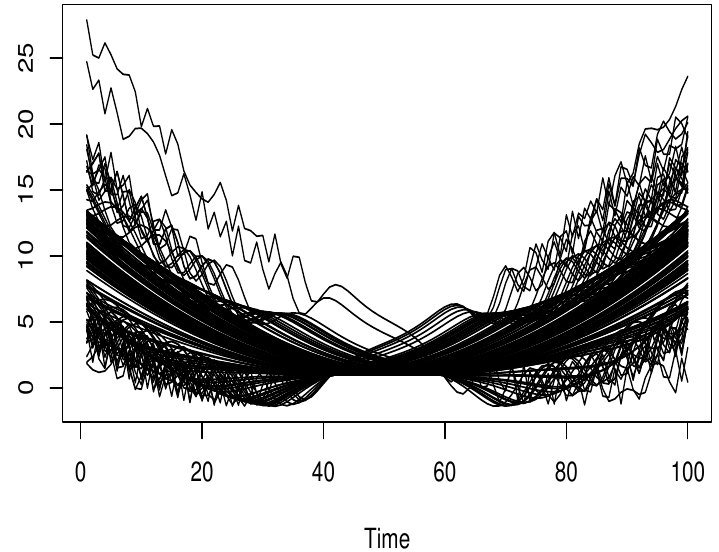
Figure 1. A sample of the functional